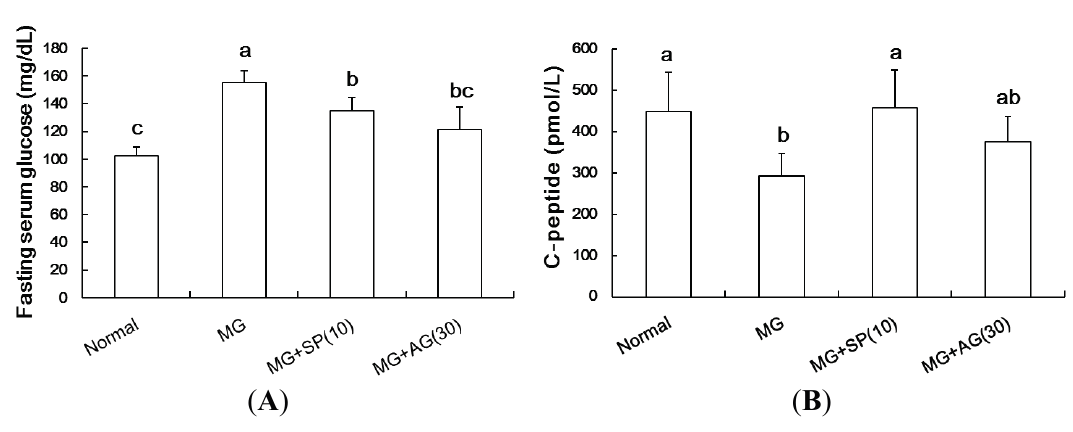
Figure 3. The effects of scopoletin (SP) and aminoguanidine (AG) on ( A ) fasting serum glucose and ( B ) C-peptide. Data were shown as mean ± SD ( n = 8). (a–c) indicate statistically significant differences p < 0.05. Normal: deionized water; MG: methylglyoxal (300 mg/kg body weight); MG + SP (10): methylglyoxal (300 mg/kg body weight) + scopoletin (10 mg/kg body weight); MG + AG (30): methylglyoxal (300 mg/kg body weight) + aminoguanidine (30 mg/kg body weight).